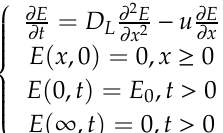
Figure 4. Boundary problem with a constant concentration at one end of the one-dimensional soil column .